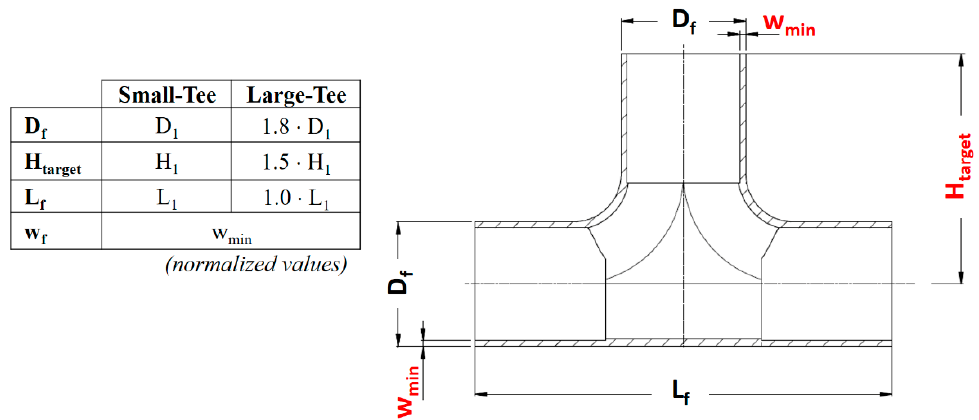
Figure 1. Geometries of the T-Joints to be manufactured by Tube Hydroforming (THF).